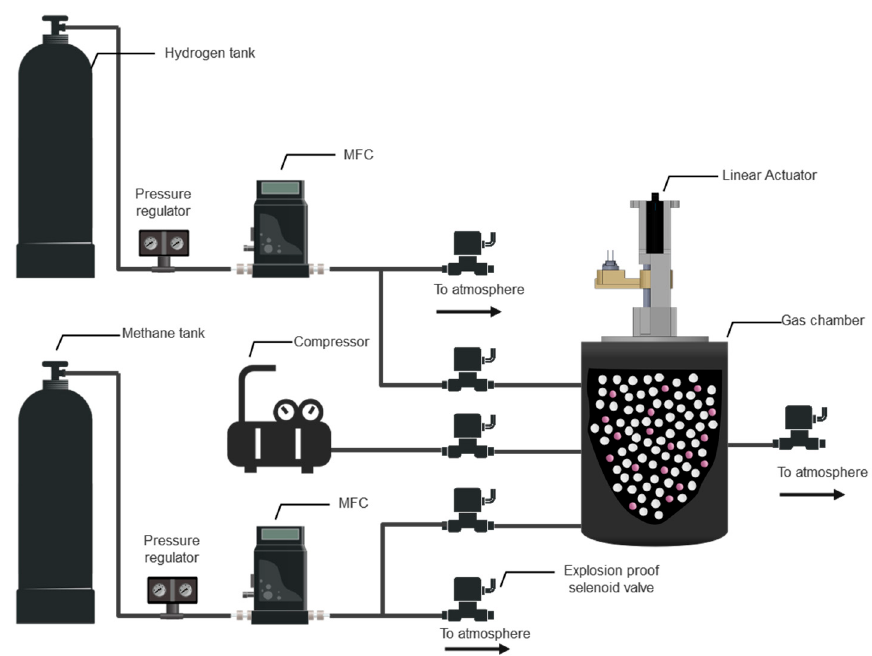
Figure 2. The schematic diagram of the automated experimental setup, designed and built for sample generation and data collection.